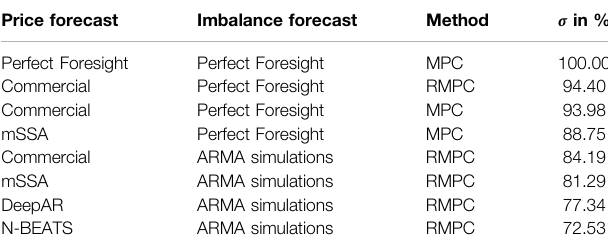
TABLE 4 | The σ -value for MPC/RMPC and different forecast